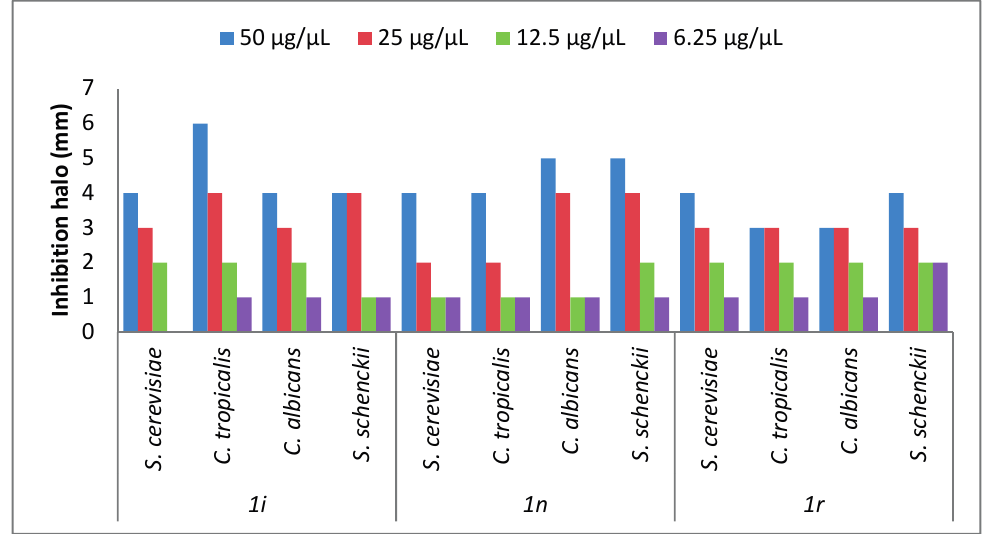
Figure 2. Antifungal Activity of 1i , 1n , and 1r chromone-tretrazoles. The effect of chromone-tetrazoles in solid medium was measured as described in the Experimental